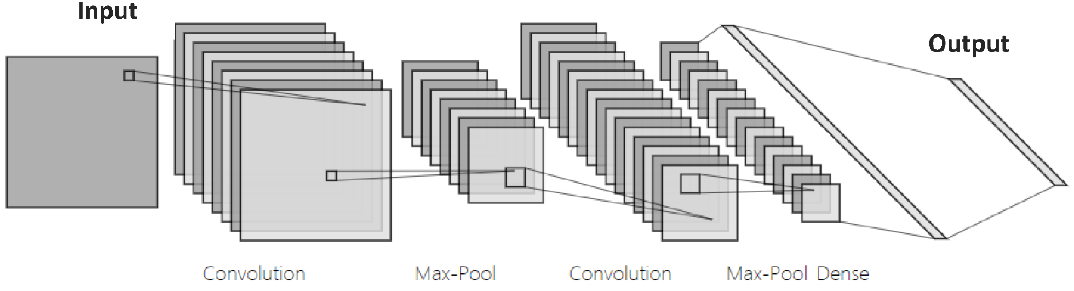
Figure 1. The structure of a convolutional neural network [27].